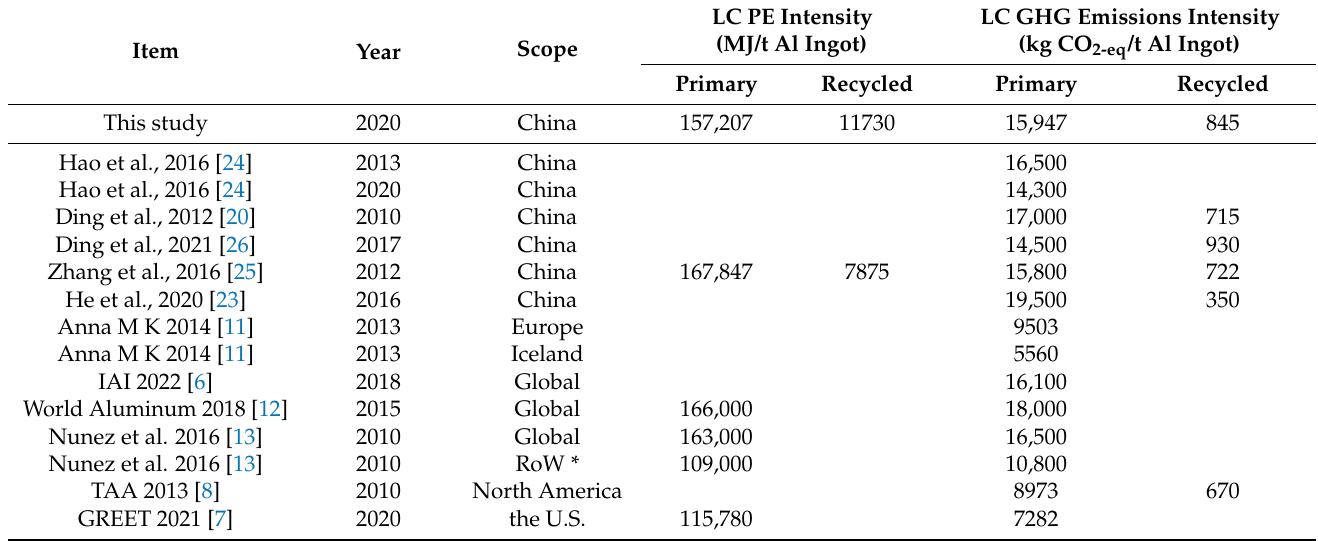
Table 6. LC results from different